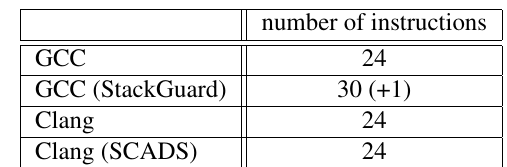
Table 3. Listing of the number of machine instructions generated for the fibonacci function from listing 17 by GCC, GCC(StackGuard), Clang and Clang(SCADS).